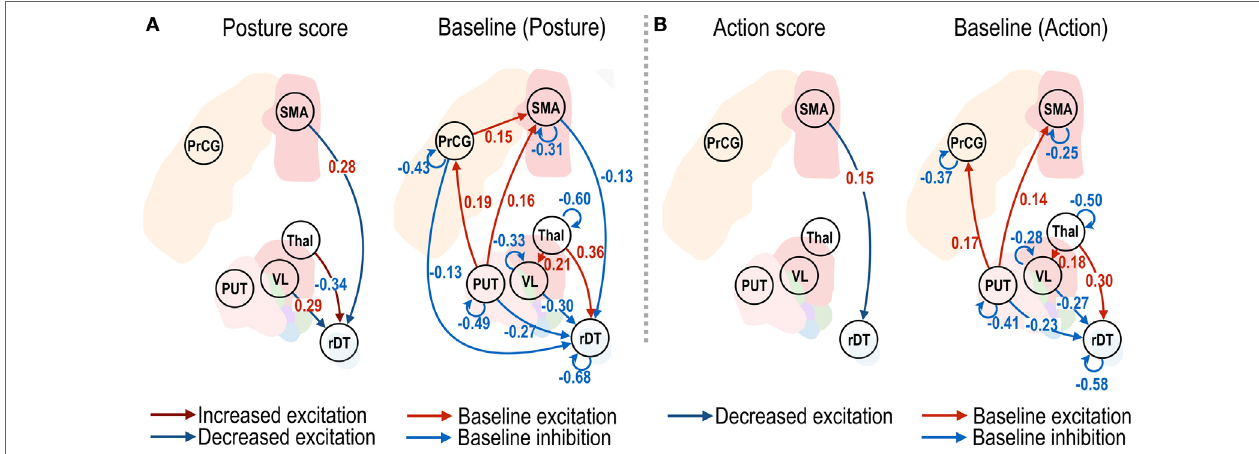
FIgURe 4 | Effective connectivity of motor subnetwork associated with posture and action scores. The dark blue and dark red arrows in left panels of (A,B) show positive and negative effect sizes (i.e., red and blue colored numbers), indicating decreased and increased effective connectivity with reduced symptom severity. Connectivity changes that survived a non-zero criterion with a posterior confidence of 95% are displayed in the graphs. VL, ventrolateral thalamic nucleus; PrcG, precentral gyrus; SMA, supplementary motor area; Thal, non-VL thalamic nuclei; Put, putamen in the left hemisphere; rDT, right dentate nucleus in the cerebellum. op − 1d, op + 7d, and op + 3m indicate 1 day before treatment, 7 days, and 3 months after